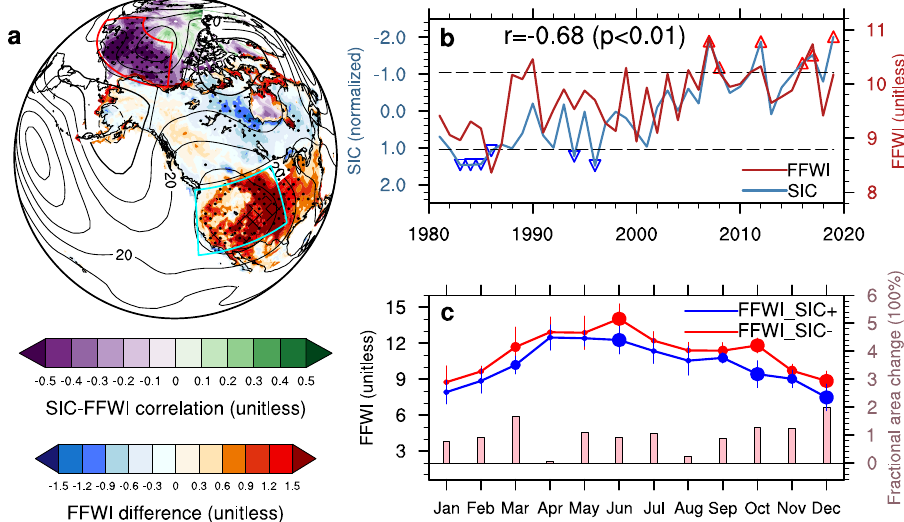
Fig. 1 Observation- and reanalysis-based teleconnection between Arctic sea ice and regional fi re. a Spatial distributions of the correlation (shading in the Arctic as denoted by the purple-green color bar) between seasonal average Arctic sea-ice concentrations (SIC) in summer and autumn (July to October) and a seasonal and regional average fi re weather index (FFWI) over the western U.S. in the following autumn and early winter (September to December), and the difference of seasonal average FFWI (shading in North America as denoted by the blue-red color bar) between the years with minimum (SIC − : red up-pointing triangles in b ) and maximum (SIC + : blue down-pointing triangles in b ) Arctic SIC. The difference of seasonal (September to December) average geopotential height at 500 hPa between the SIC − and SIC + years is also shown in a (contours with negative values in dashed lines; unit: m). Stipples in a mark regions that are signi fi cantly different from 0 at the 0.05 signi fi cance level of two-sided t -tests, and hatching in a denotes statistically ¼ 0 : 0023 at the threshold of α ¼ 0 : 10. signi fi cant regions based on the stricter FDR method (see Methods section) with local gridded p -value (cid:1) p (cid:3) FDR FDR b Time series of seasonal and regional average SIC (seasonal mean from July to October; normalized by its 1981 – 2010 climatological mean and standard deviation; note its scale on the left Y -axis is inverted to directly compare temporal variations of both time series), FFWI (seasonal mean from September to December), and their correlation. The region de fi nitions for the Paci fi c sector of the Arctic and the western U.S. are outlined by the red and cyan boxes in a , respectively. The horizontal dashed lines denote the ±1 standard deviations of normalized SIC as thresholds for selecting the SIC± years. c The composite of monthly FFWI (solid lines with dots and error bars) and fractional burned area change of large wild fi res (vertical bars) over the western U.S. Error bars in c denote ±1 standard deviations of monthly FFWI in each group. Dot sizes for monthly FFWI in c Denote the 0.05 (large),0.1 (medium), and non-signi fi cant (small) signi fi cance levels of two-sided t -tests for monthly FFWI differences between the years with minimum (FFWI_SIC − ) and maximum (FFWI_SIC + ) Arctic SIC,